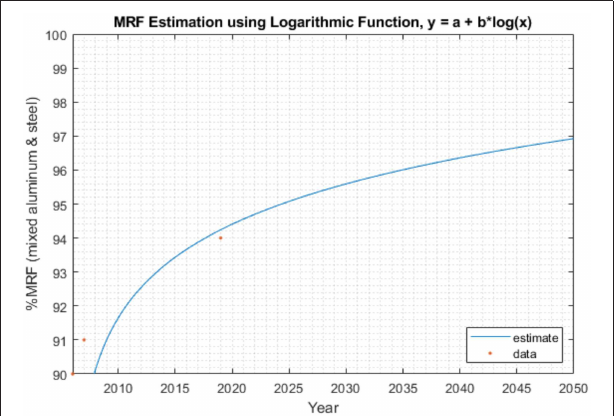
FIGURE 4 | The estimation of MRF values of pure steel.